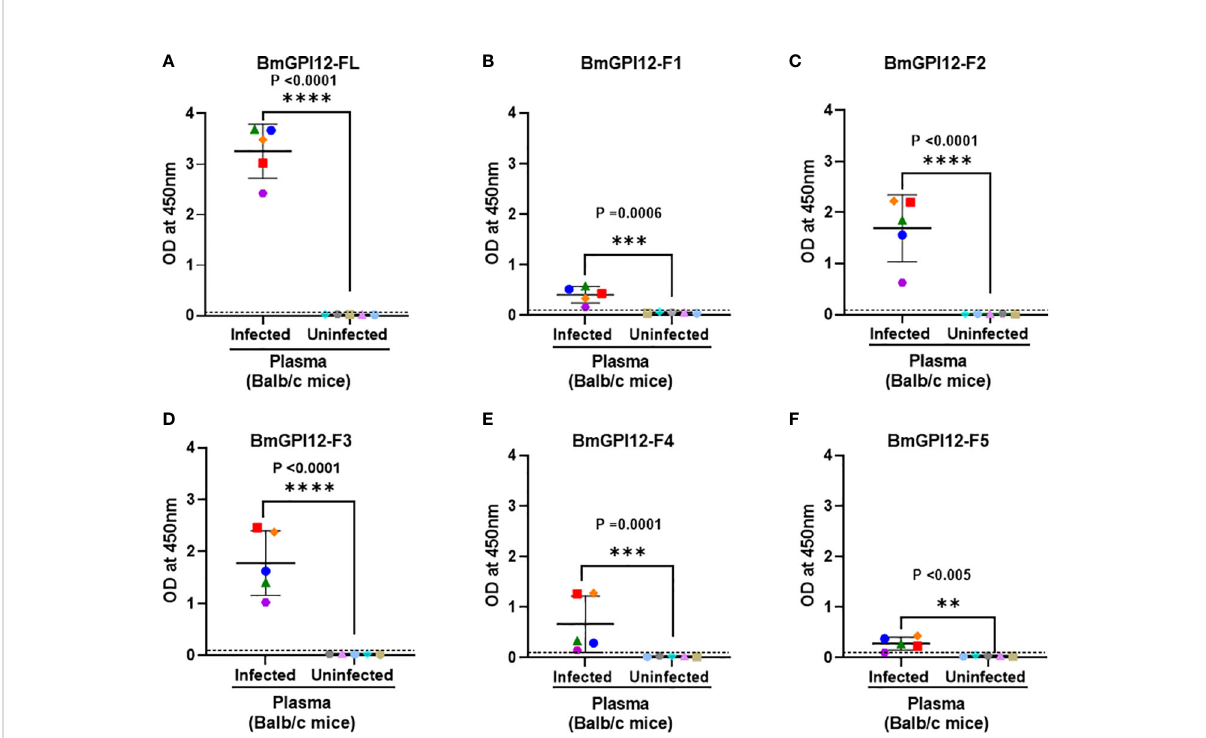
FIGURE 5 Detection of full length BmGPI12 or its sub-fragments by indirect ELISA using uninfected or B microti -infected mouse plasma. Heat inactivated plasma from B microti -infected or uninfected Balb/c mice were used (1:200 dilution) to detect recombinant BmGPI12-FL or sub-fragments F1, F2, F3, F4 or F5 coated on ELISA plates at 50 ng/well. In all graphs, one color represents the reactivity of each mouse plasma sample to different BmGPI12 antigens- FL (A) , F1 (B) , F2 (C) , F3 (D) , F4 (E) and F5 (F) . Each assay was conducted more than once with at least two technical replicates per assay. Error bars denote the standard deviation calculated using the Graphpad Prism 9.3 software. OD 450 cut-off (dashed line) was determined as the mean + 2 x SD of the OD 450 value of the uninfected samples. ****: statistically signi fi cant (p<0.0001, by two-way ANOVA); ***: statistically signi fi cant (p<0.0006, by two-way ANOVA); **: statistically signi fi cant (p<0.005, by two-way